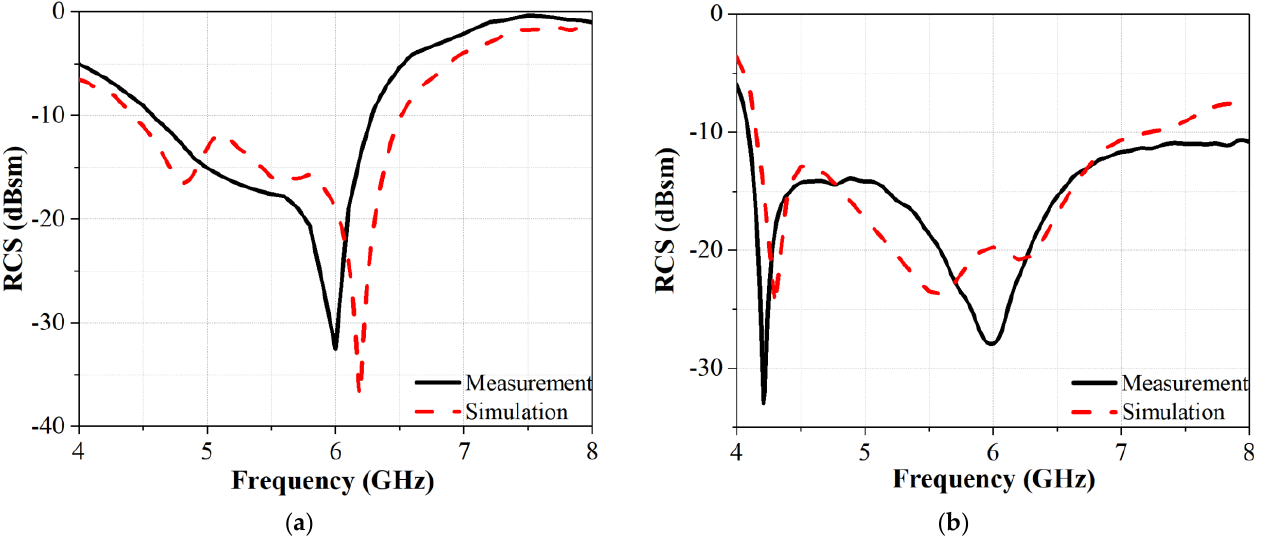
Figure 25. Measured and simulated monostatic RCS of the proposed array antenna for vertical incident plane waves. ( a ) x −polarized; ( b ) y −polarized.